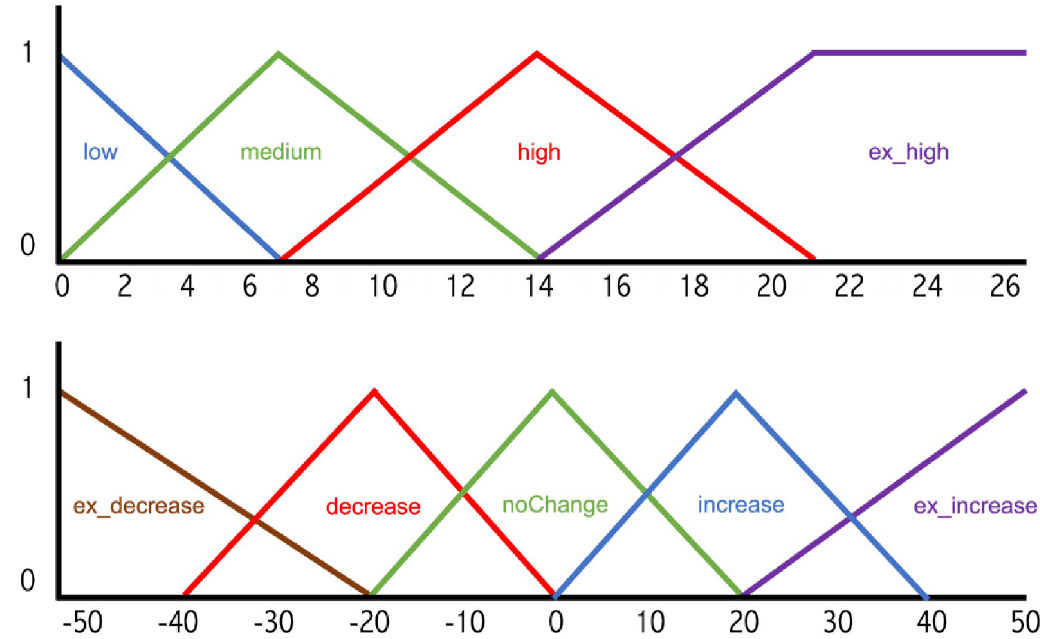
Fig 2. Algorithm membership function. (Top) Input Membership Function. The algorithm classifies glucose input into 4 sets: low, medium, high, and ex_high. The x-axis plots blood glucose values and the y-axis plots the range of truth value from 0 to 1. (Bottom) Output Membership Function involved in the center of gravity defuzzification process to produce basal-rate insulin changes.